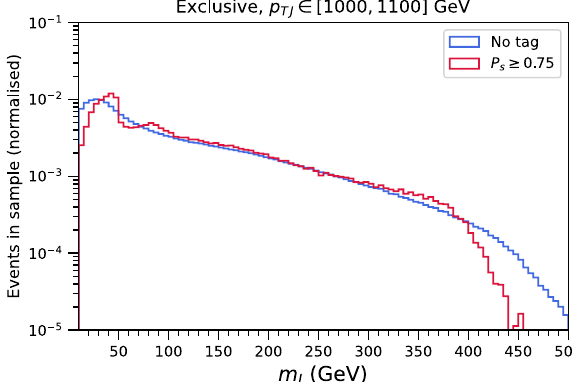
≥ 0 . 75 with the s